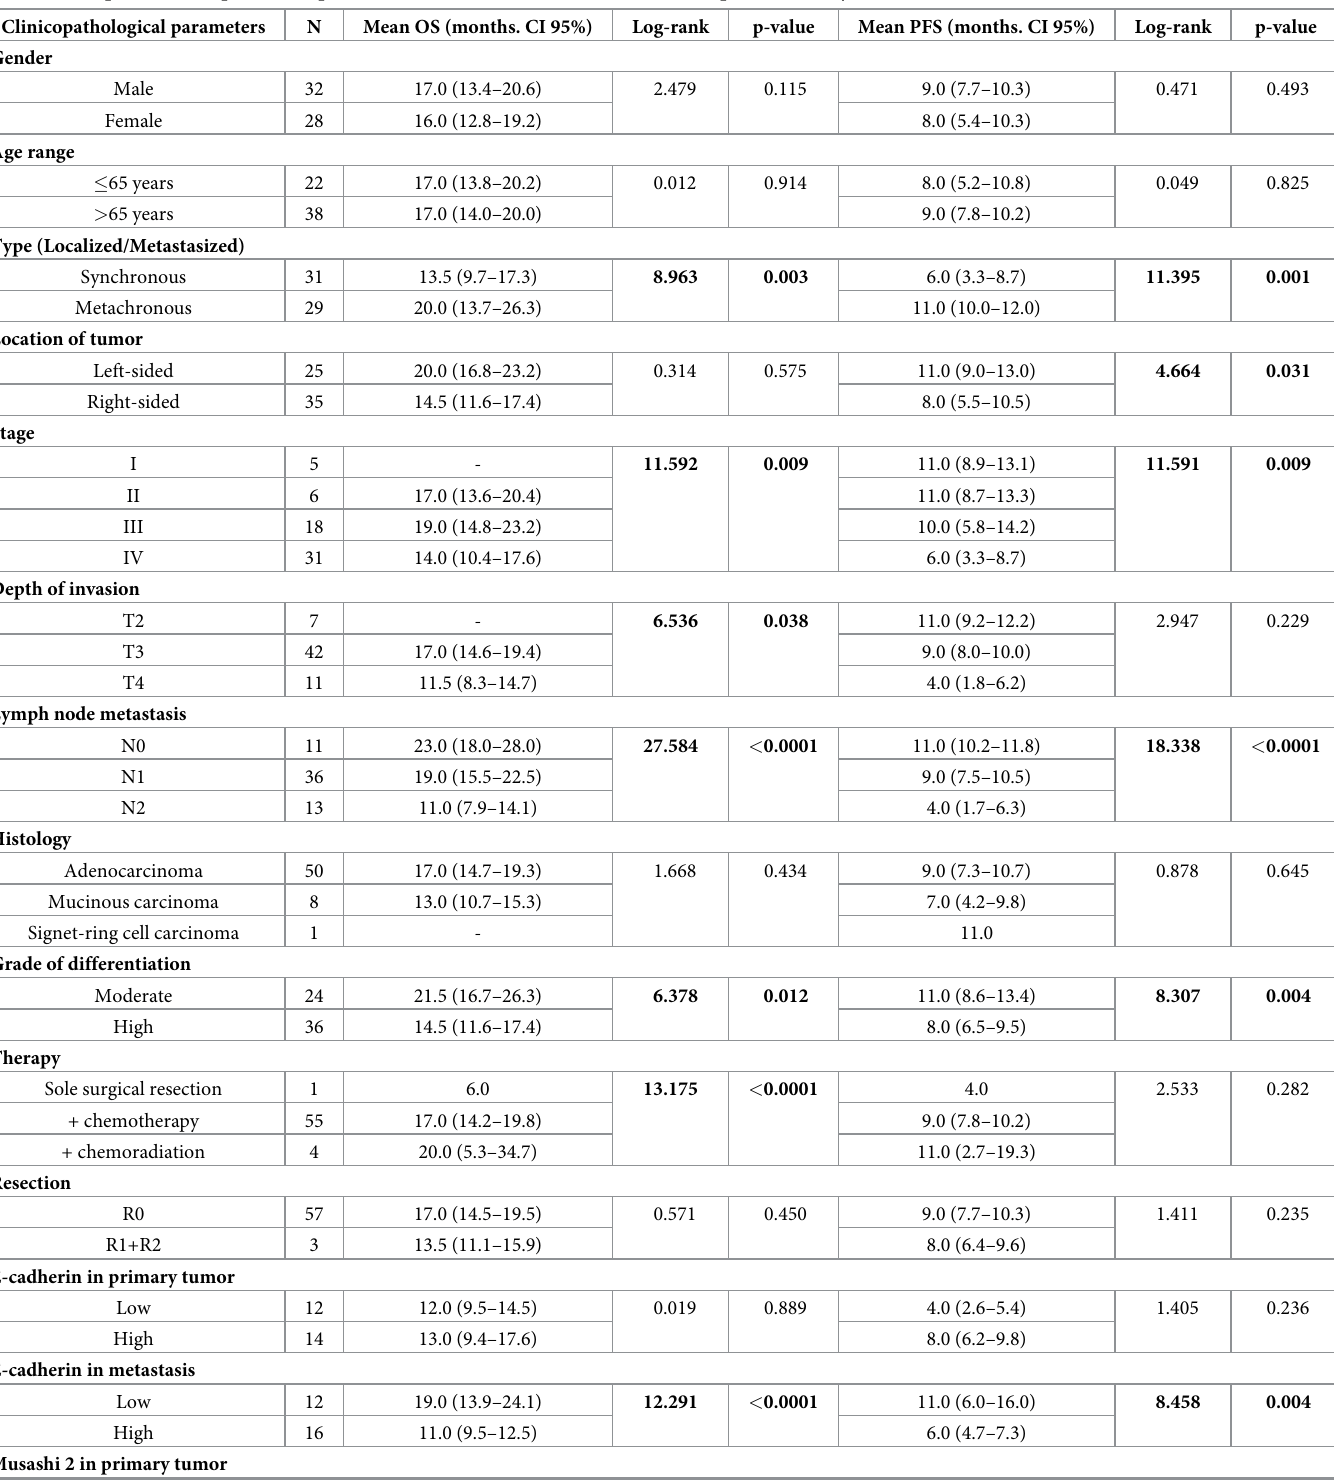
Table 3. Comparison of frequencies of qualitative indicators with OS and PFS in mCRC patients with synchronous and metachronous metastasis. Clinicopathological